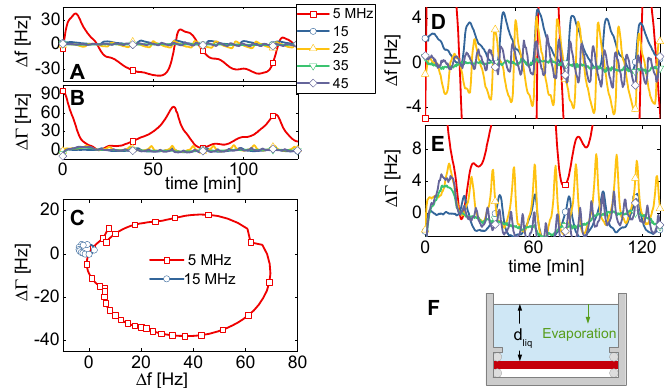
Figure 7. When mounting the resonator horizontally in an open cell ( F ) and letting the liquid evaporate, one observes coupled resonances ( A – C ). The vertical enlargement ( D and E ) shows the coupled resonances on the overtones. Because of the reduced wavelength, these are more densely spaced than the coupled resonances on the fundamental mode. Furthermore, and more importantly, they occur at a much-reduced amplitude. Table 3. Diameters of circles seen in the polar diagram (Figure 7C). f (MHz) diameter of circle (Hz) f (MHz)